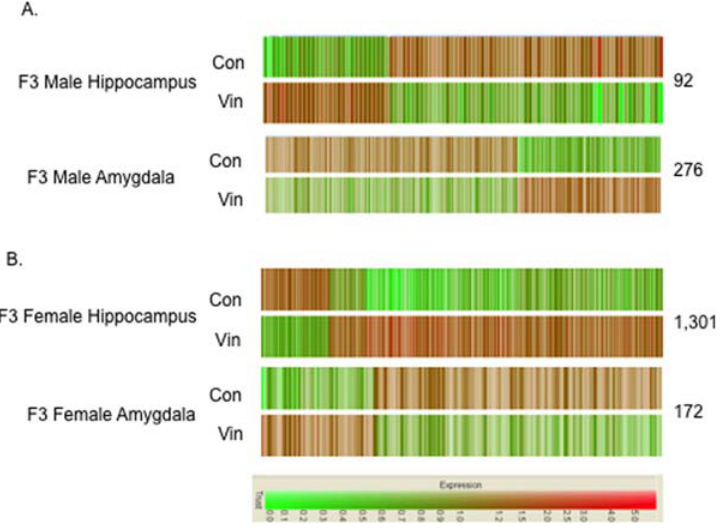
Figure 1. Brain transcriptome microarray analysis from F3 generation control (con) and vinclozolin (vin) animals. (A) Dendrogram for male whole brain, male hippocampus and male amygdala for statistically significant regulated genes with signal above 75. (B) Dendrogram for female hippocampus or female amygdala for statistically significant regulated genes. The scale at the bottom margin indicates an increase (red) and decrease (green) in expression. The number of regulated genes is listed at the right of each gene set. The whole male brain was from 6 month old animals, and amygdala and hippocampus from 12–15 month old animals.